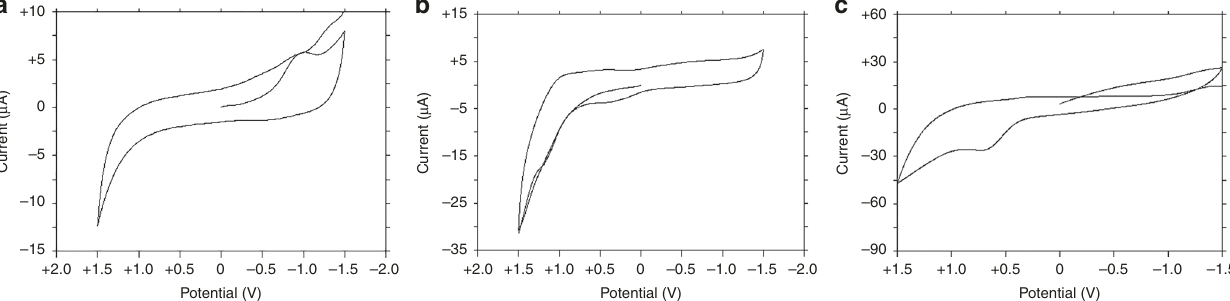
Fig. 4 Electrochemical behavior of 1 . Cyclic voltammograms of 1 in ( a ) acetonitrile, ( b ) propylene carbonate, and ( c ) dichloromethane with 0.1 M